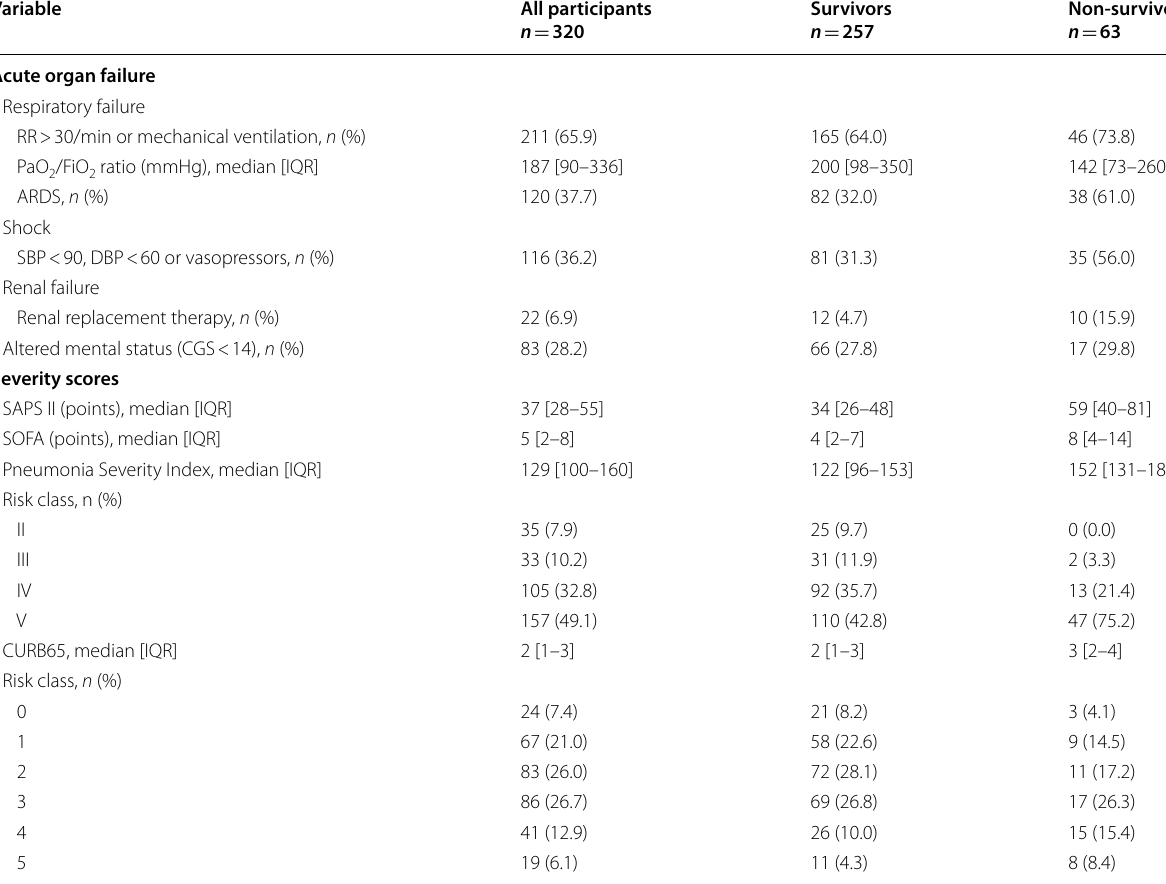
Table 2 Severity of the disease during the first 24 hours of ICU/ICW